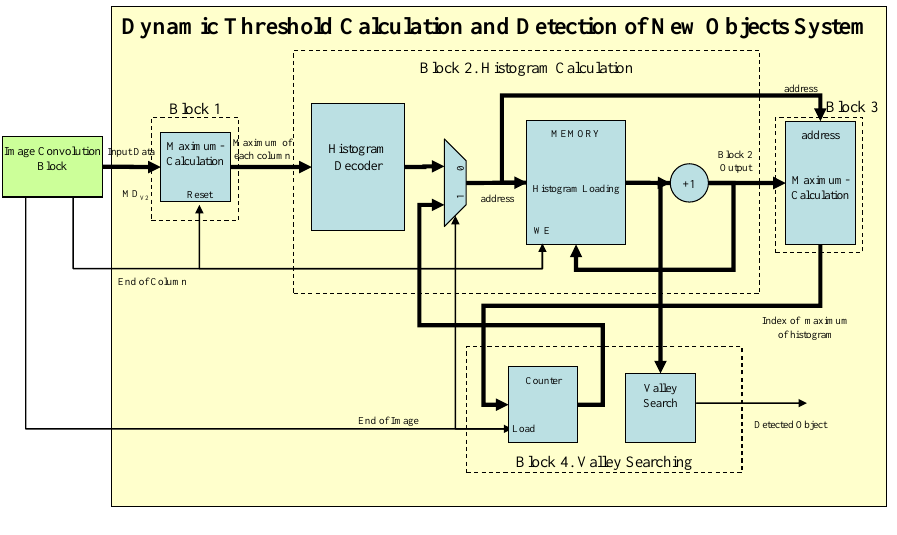
Figure 7. Block diagram on an FPGA of the dynamic threshold calculating system for detecting new objects.